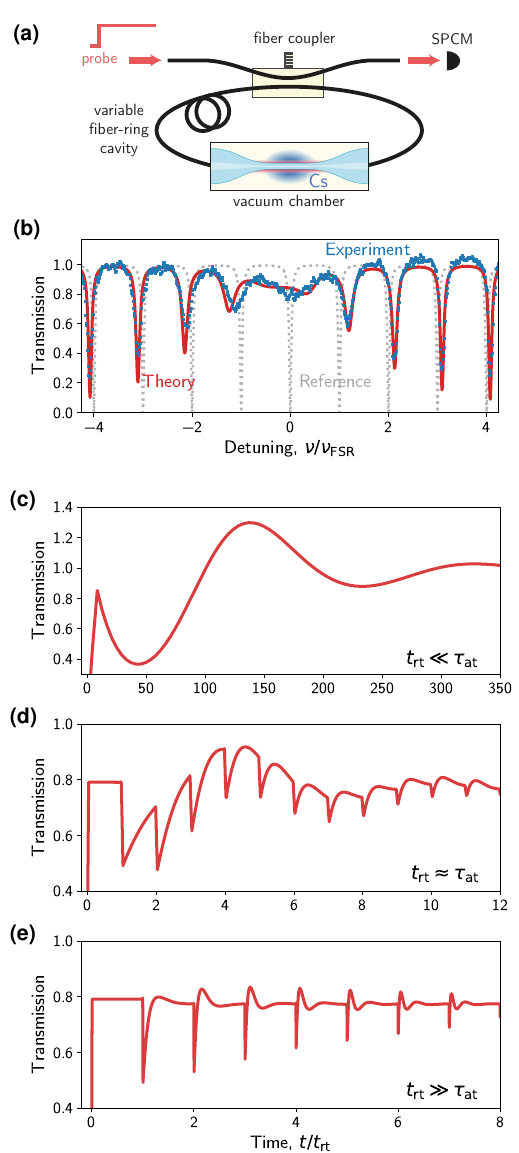
Figure 1: (a) Experimental setup of our fiber-ring cavity system. (b) Frequency scan of the cavity transmission for a 45-m-long cavity with frequency normalized to the free spectral range ν FSR of the resonator. Experimental data is represented as blue dots, theory as a red solid line and ref- erence cavity as a grey dotted line. In this case, the atomic ensemble interacts with multiple resonator modes at the same time. (d) - (e) The transmission through cavities with increasing lengths as predicted by the cascaded interac- tion model with time normalized to the roundtrip time of the resonator. The longer the resonator and the longer its roundtrip time, t rt , is compared to the lifetime of the atoms, τ at , the more the typical Rabi oscillations of cavity QED disappear and the more the repeating single-pass dynamics of waveguide QED